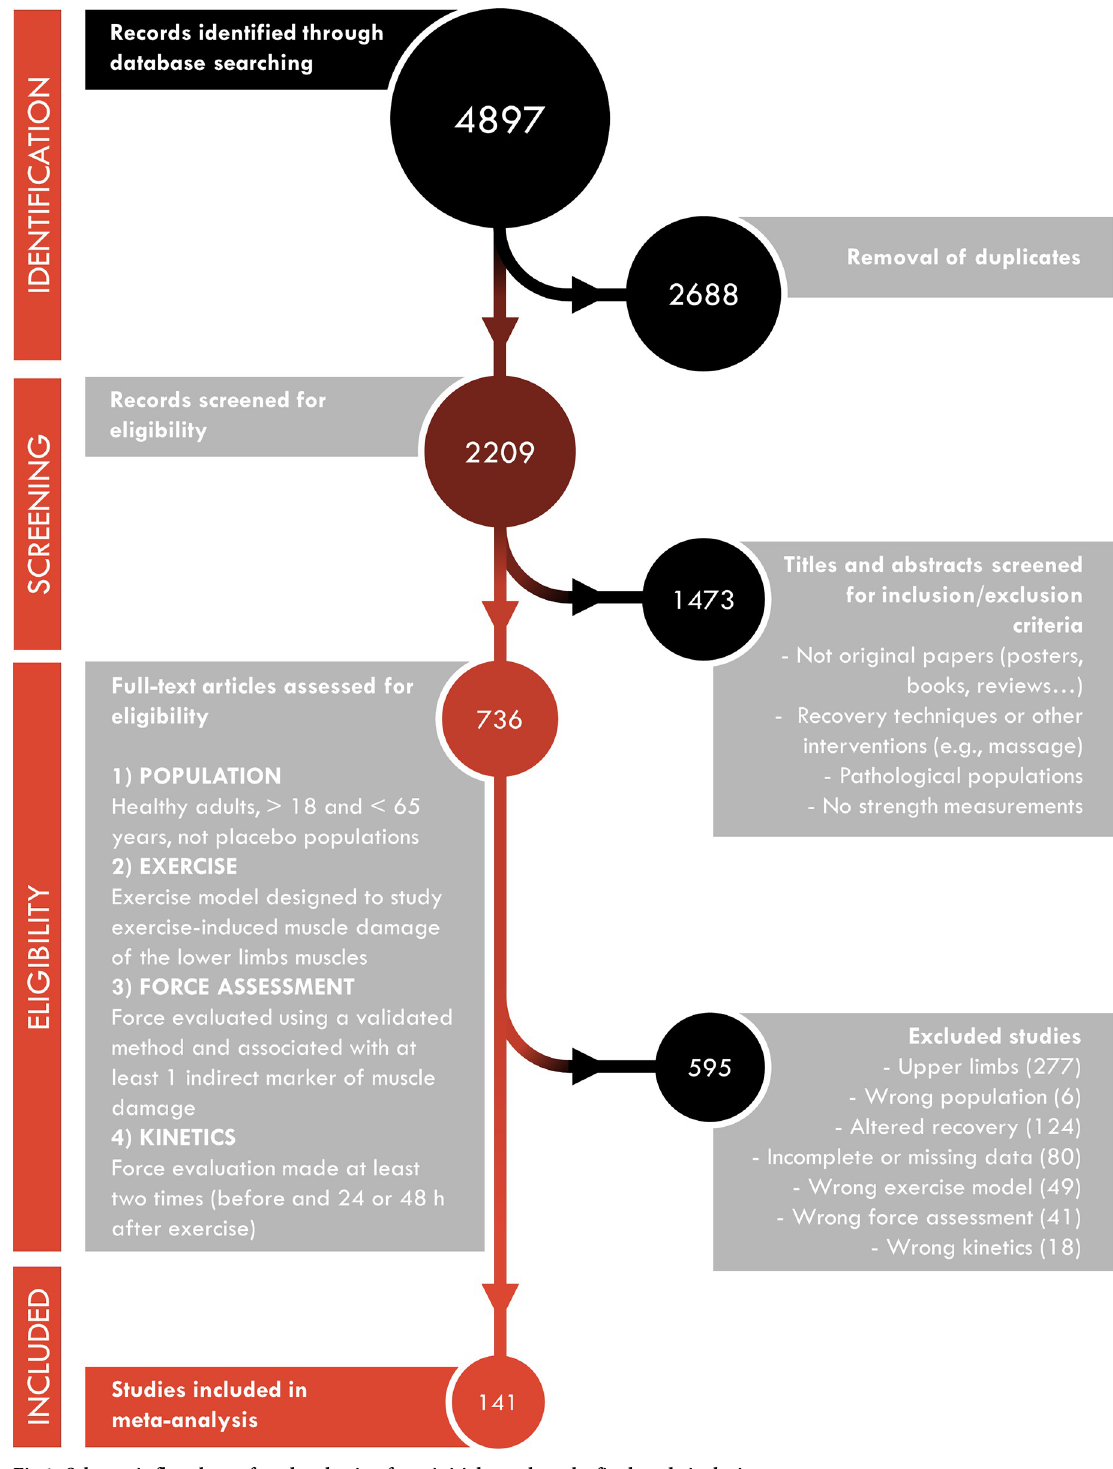
Fig 1. Schematic flowchart of study selection from initial search to the final study inclusion.